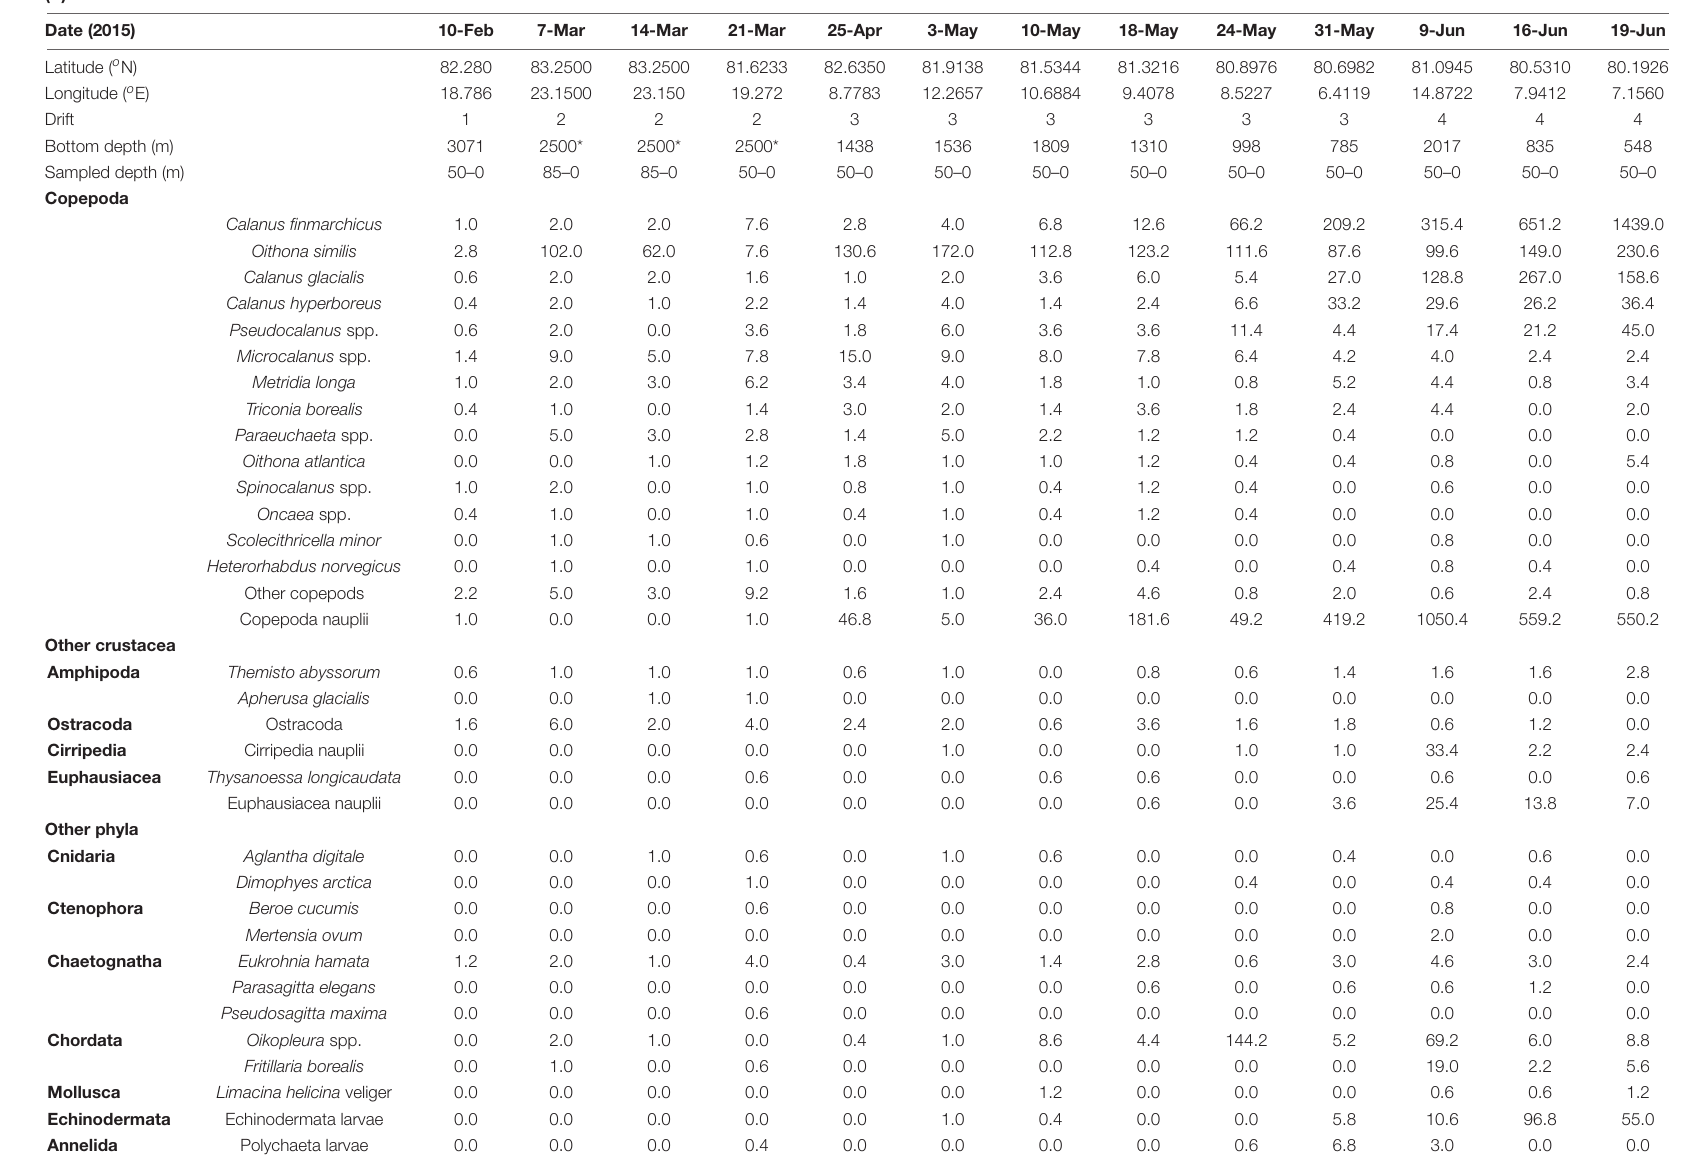
TABLE 2 | Abundance of main zooplankton taxa (ind. m − 3 ) in the Arctic Ocean at 0–50 m depth (A) , 50–200 m depth (B) , and 200 m to near bottom (C) .